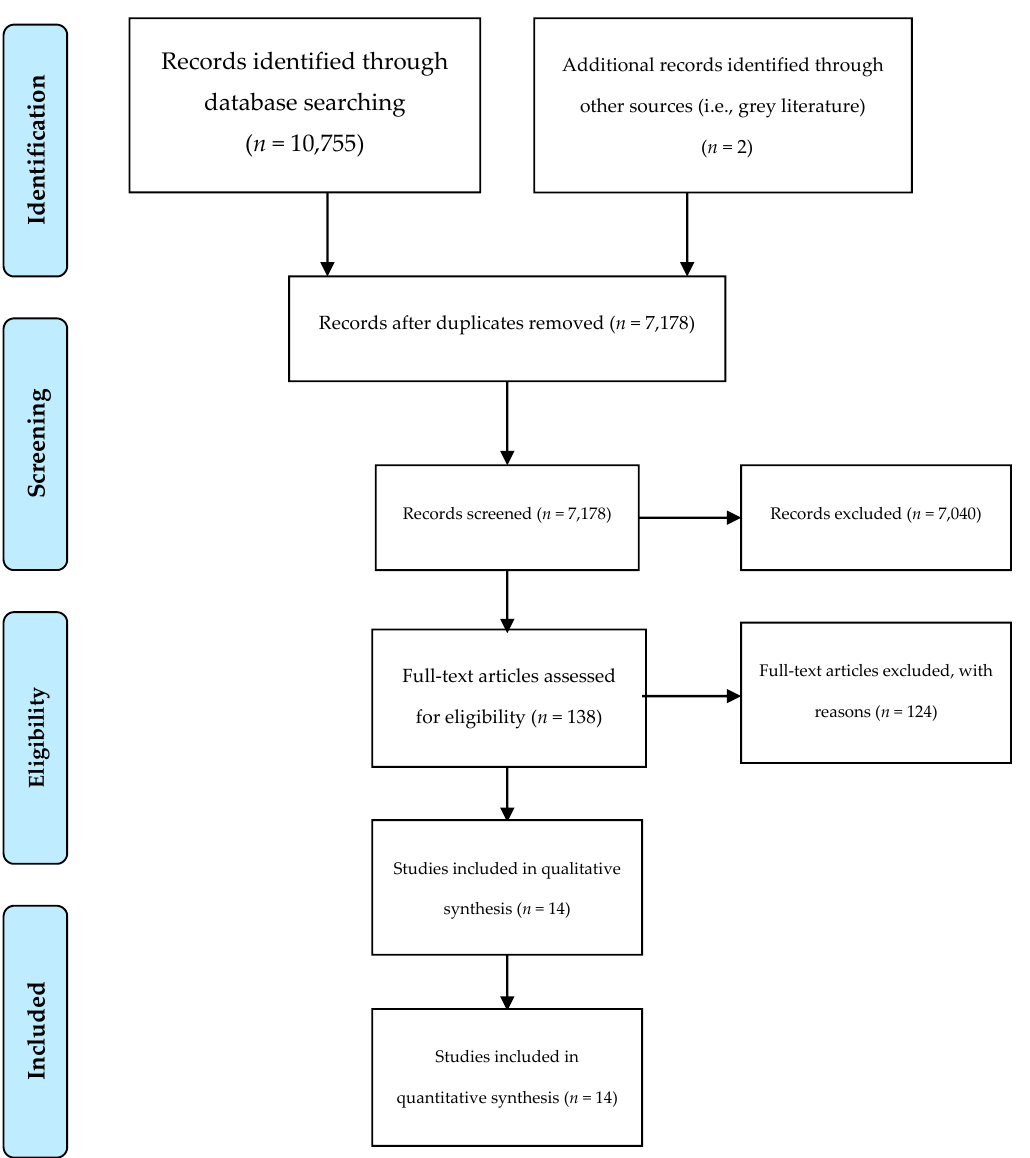
Figure 1. Preferred Reporting Items for Systematic Reviews and Meta-Analyses (PRISMA) four-phase flow diagram of the literature search results. From: Moher, D.; Liberati, A.; Tetzlaff, J.; Altman, D.G.; The PRISMA Group. Preferred reporting items for systematic reviews and meta-analyses: The PRISMA statement. PLoS Med. 2009 , 6 , e1000097, doi:10.1371/journal.pmed1000097 [21]. For more information, visit www.prisma-statement.org.